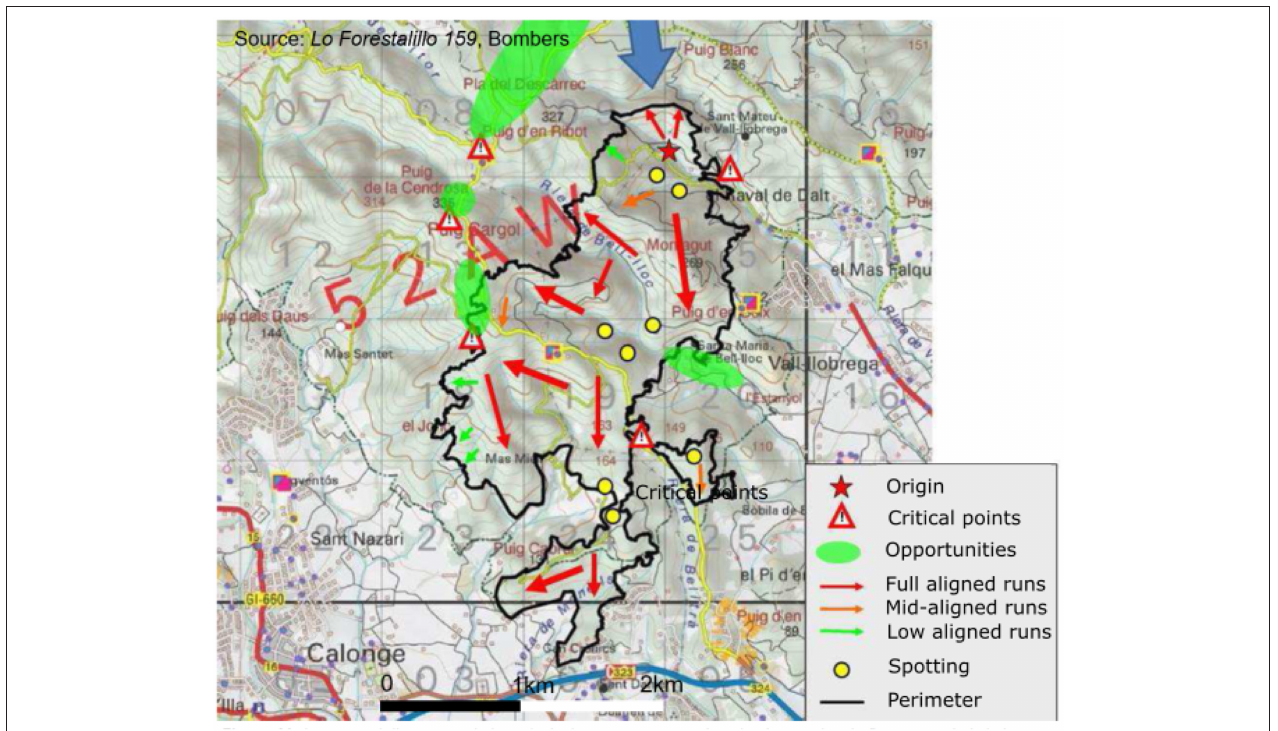
FIGURE 1 | Vall-llobrega fire development and final perimeter. Source: GRAF (2014),